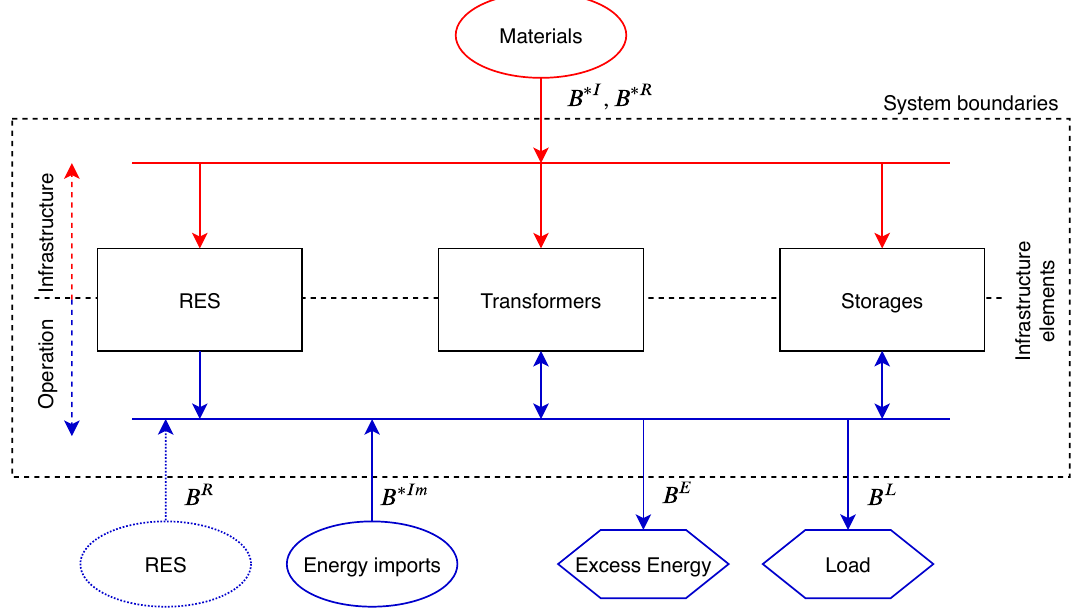
Figure 3. Cumulative exergetic consumption (CExC) flows, equivalent periodic CExC flows and exergy flows in an energy system. (Source: own